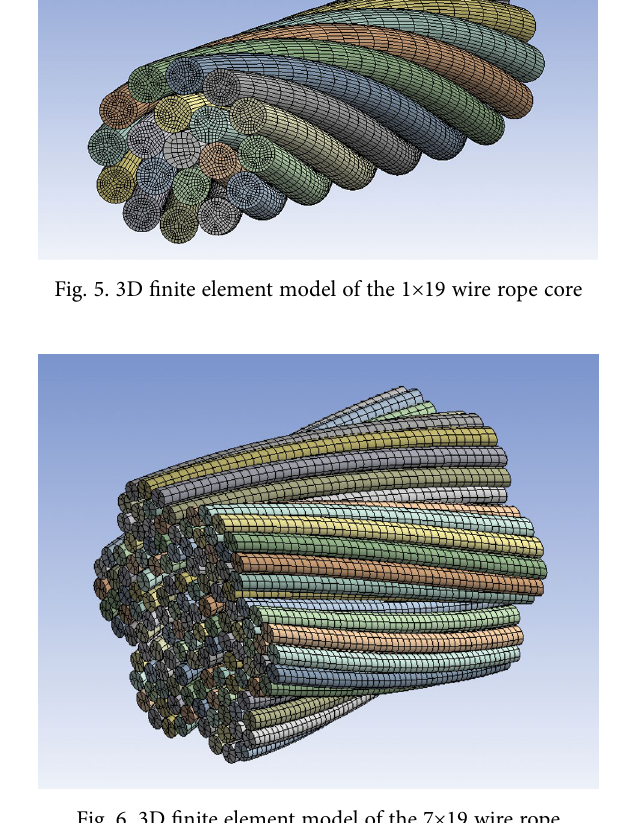
Fig. 6. 3D finite element model of the 7 × 19 wire